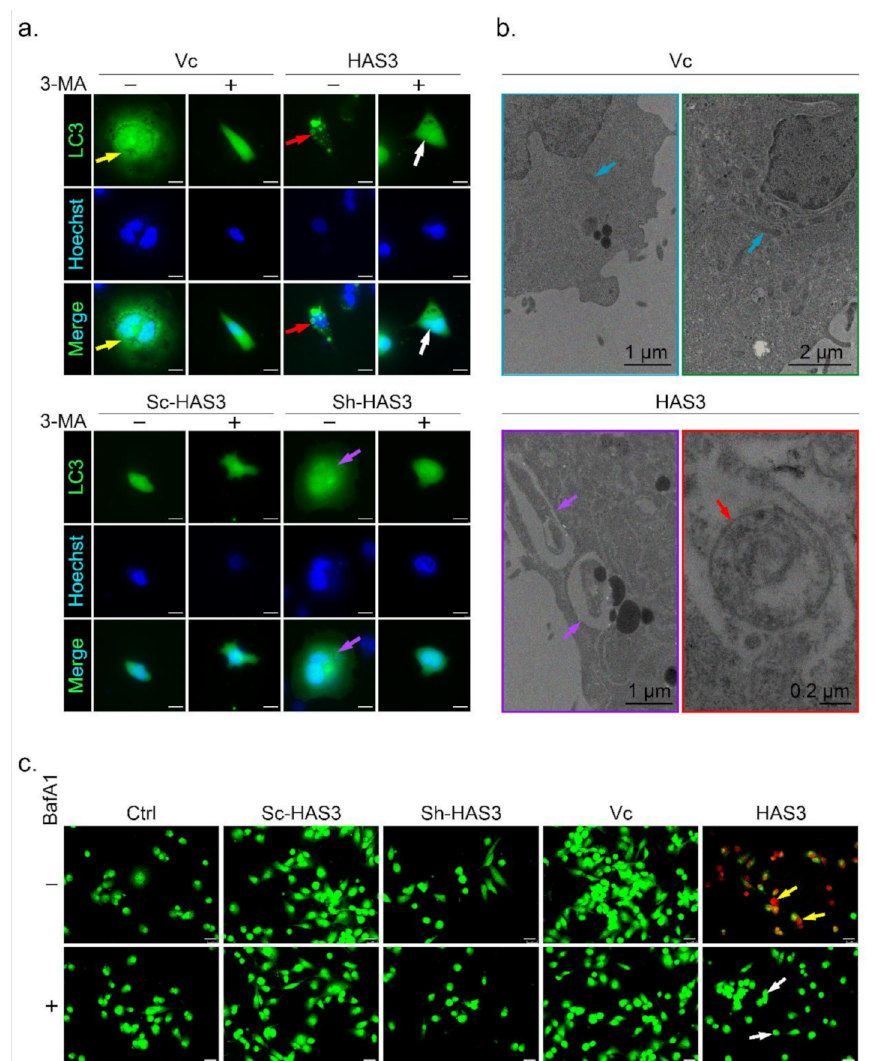
Figure 5. HAS3 overexpression induced autophagic cell death in breast cancer cells. ( a ) HAS3 overexpression in MDA- MB-231 cells increased LC3-GFP punctate formation. The live transfected cells were imaged by DeltaVision microscopy. A diffuse nuclear and cytosolic punctate signal for LC3-GFP, indicating autophagic cells, was detected in LC3-GFP plasmid- and HAS3-pcDNA3.1 plasmid-cotransfected MDA-MB-231 cells (red arrow), but not LC3-GFP plasmid- and pcDNA3.1 plasmid-cotransfected cells (yellow arrow). Moreover, 3-MA (0.5 mM, 24hr) pretreatment completely inhibited the LC3-GFP punctate formation indicated by the lack of autophagic cell death (white arrow). Magnification, 630 × ; scale bar, 25 µ m; +: 3-MA treatment, -: nontreatment; ( b ) MDA-MB-231 cells were transfected with HAS3-pcDNA3.1 or pcDNA3.1 plasmid and subjected to ultrastructural analysis by TEM. MDA-MB-231 cells transfected with the vector contained typically shaped organelles (blue arrow). HAS3-pcDNA3.1-transfected cells exhibited autophagic vesicles and autolysosomes containing cytoplasmic materials (red arrow). HAS3-pcDNA3.1-transfected cells also showed various mitochondria with a disorganized structure, disrupted cristae, and swollen appearance (yellow arrow). Magnification, 12000 × ; scale bar, one µ m; ( c ) MDA-MB-231 cells were transiently transfected with HAS3-pcDNA3.1 (HAS3), pcDNA3.1 (Vc), pSUPER-Sh-HAS3, and pSUPER-Sc-HAS3 plasmids for 24 h, and autophagic cells were evaluated by the AO staining method (yellow arrow). HAS3-induced AO staining was decreased when cells were pretreated with BafA1 (50 nM, for 24 h). BafA1 pretreatment completely inhibited the acidification of vacuoles indicated by the lack of red fluorescence (white arrow). Magnification, 630 × ; scale bar, 25 µ m. +: BafA1 treatment, -: